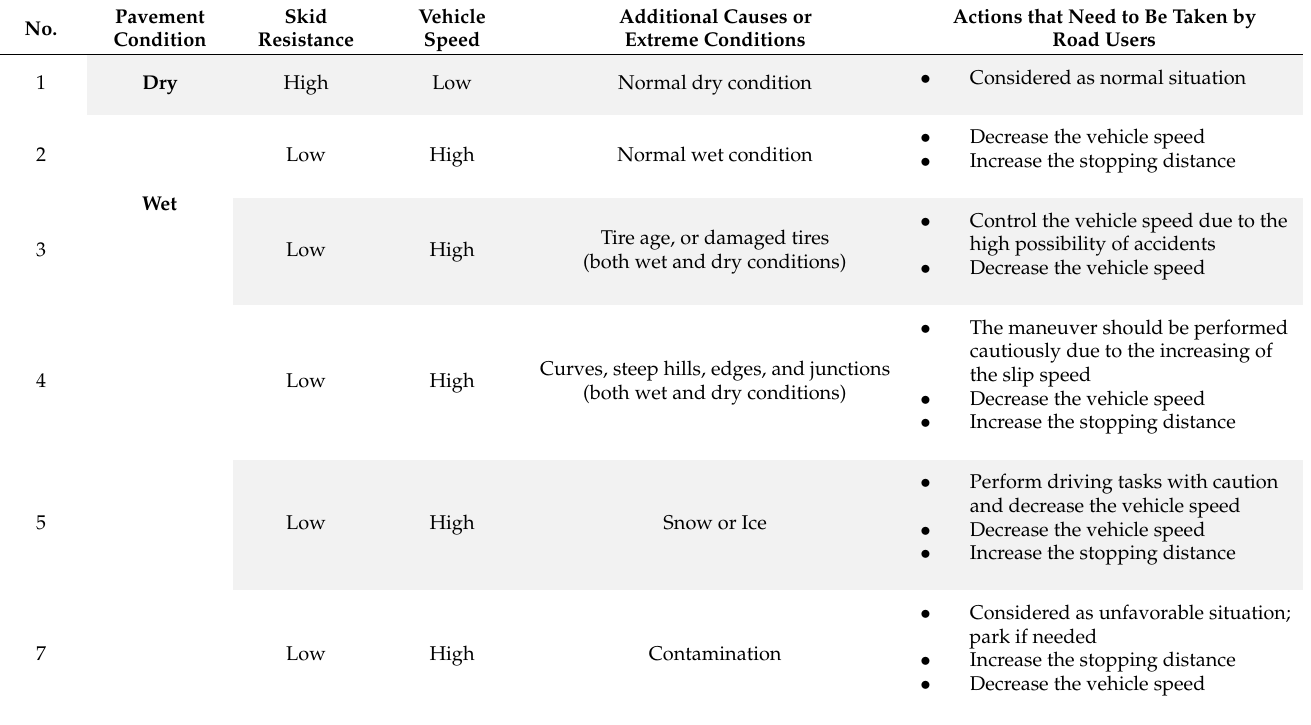
Table 3. Possible actions to be taken into consideration for various road pavement